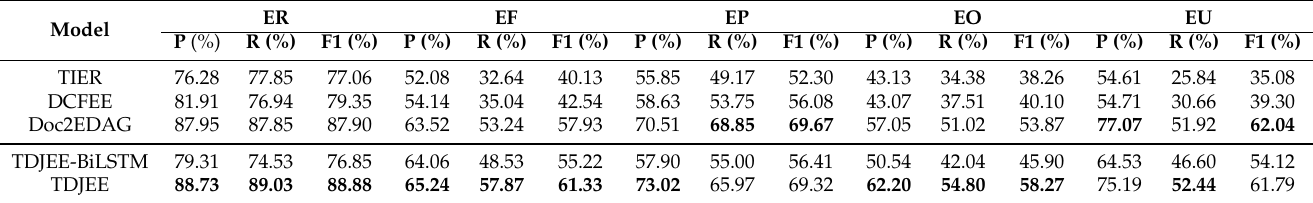
Table 5. Overall event-level precision (P.), recall (R.), and F1